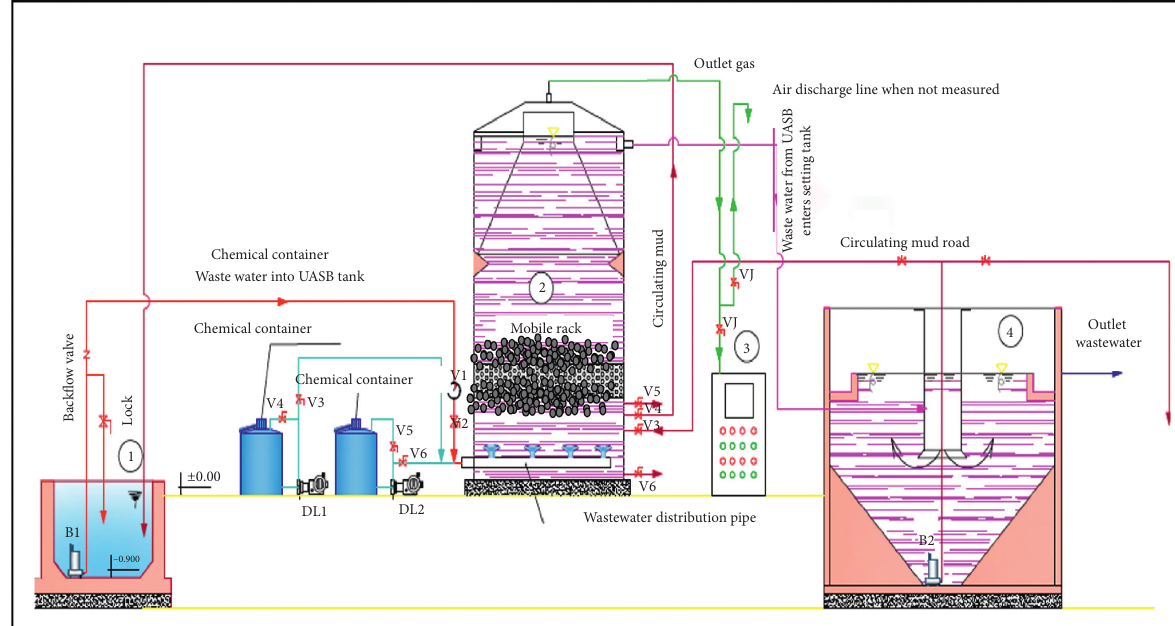
Figure 1: Schematic diagram of the pilot-scale anaerobic MBBR